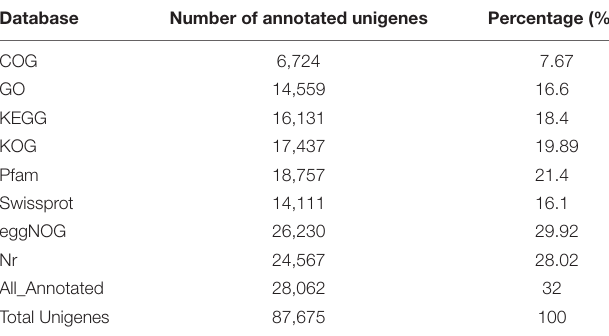
TABLE 4 | Annotation of unigenes in different